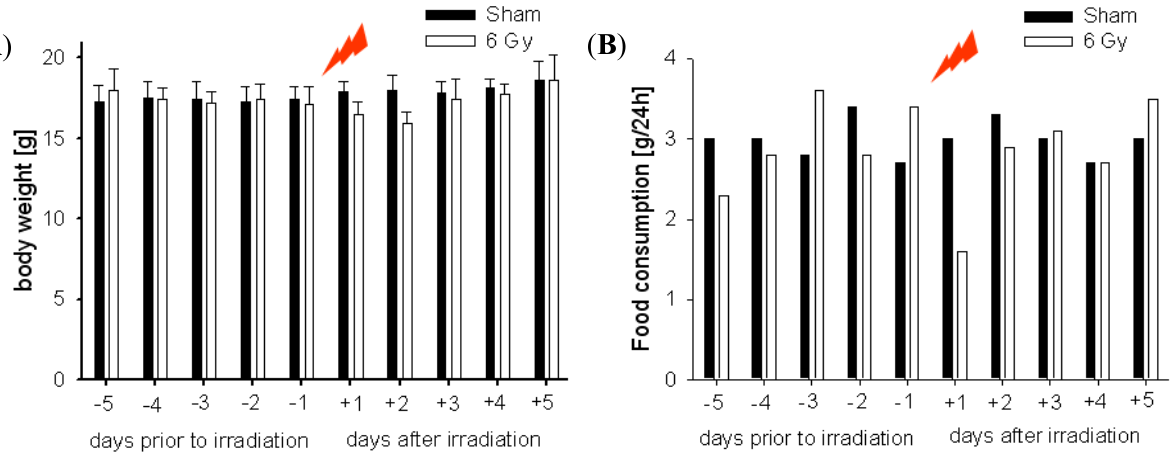
Figure 2. Trends in body weight on days -5 and +5 ( A ) in food consumption ( B ). Filled bars and open bars are for sham-irradiated and irradiated C57BL/6, respectively.